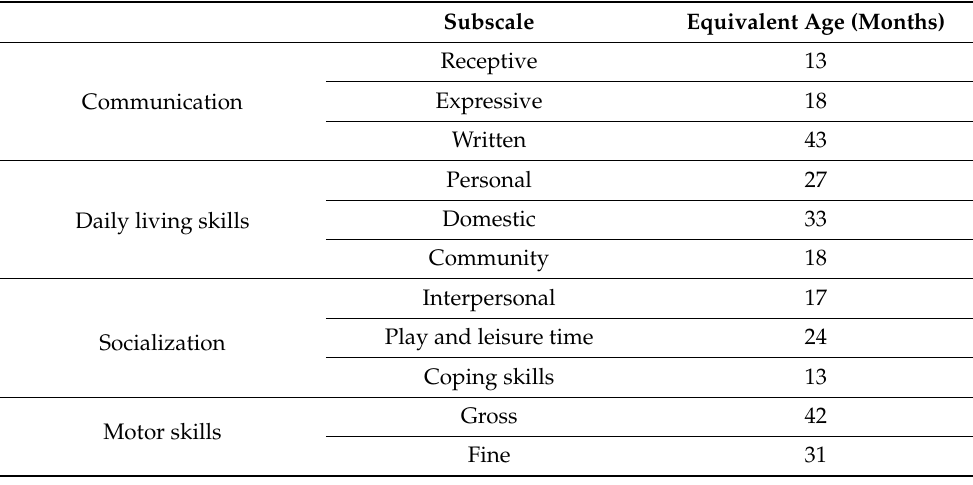
Table 2. Patient’s scores on the